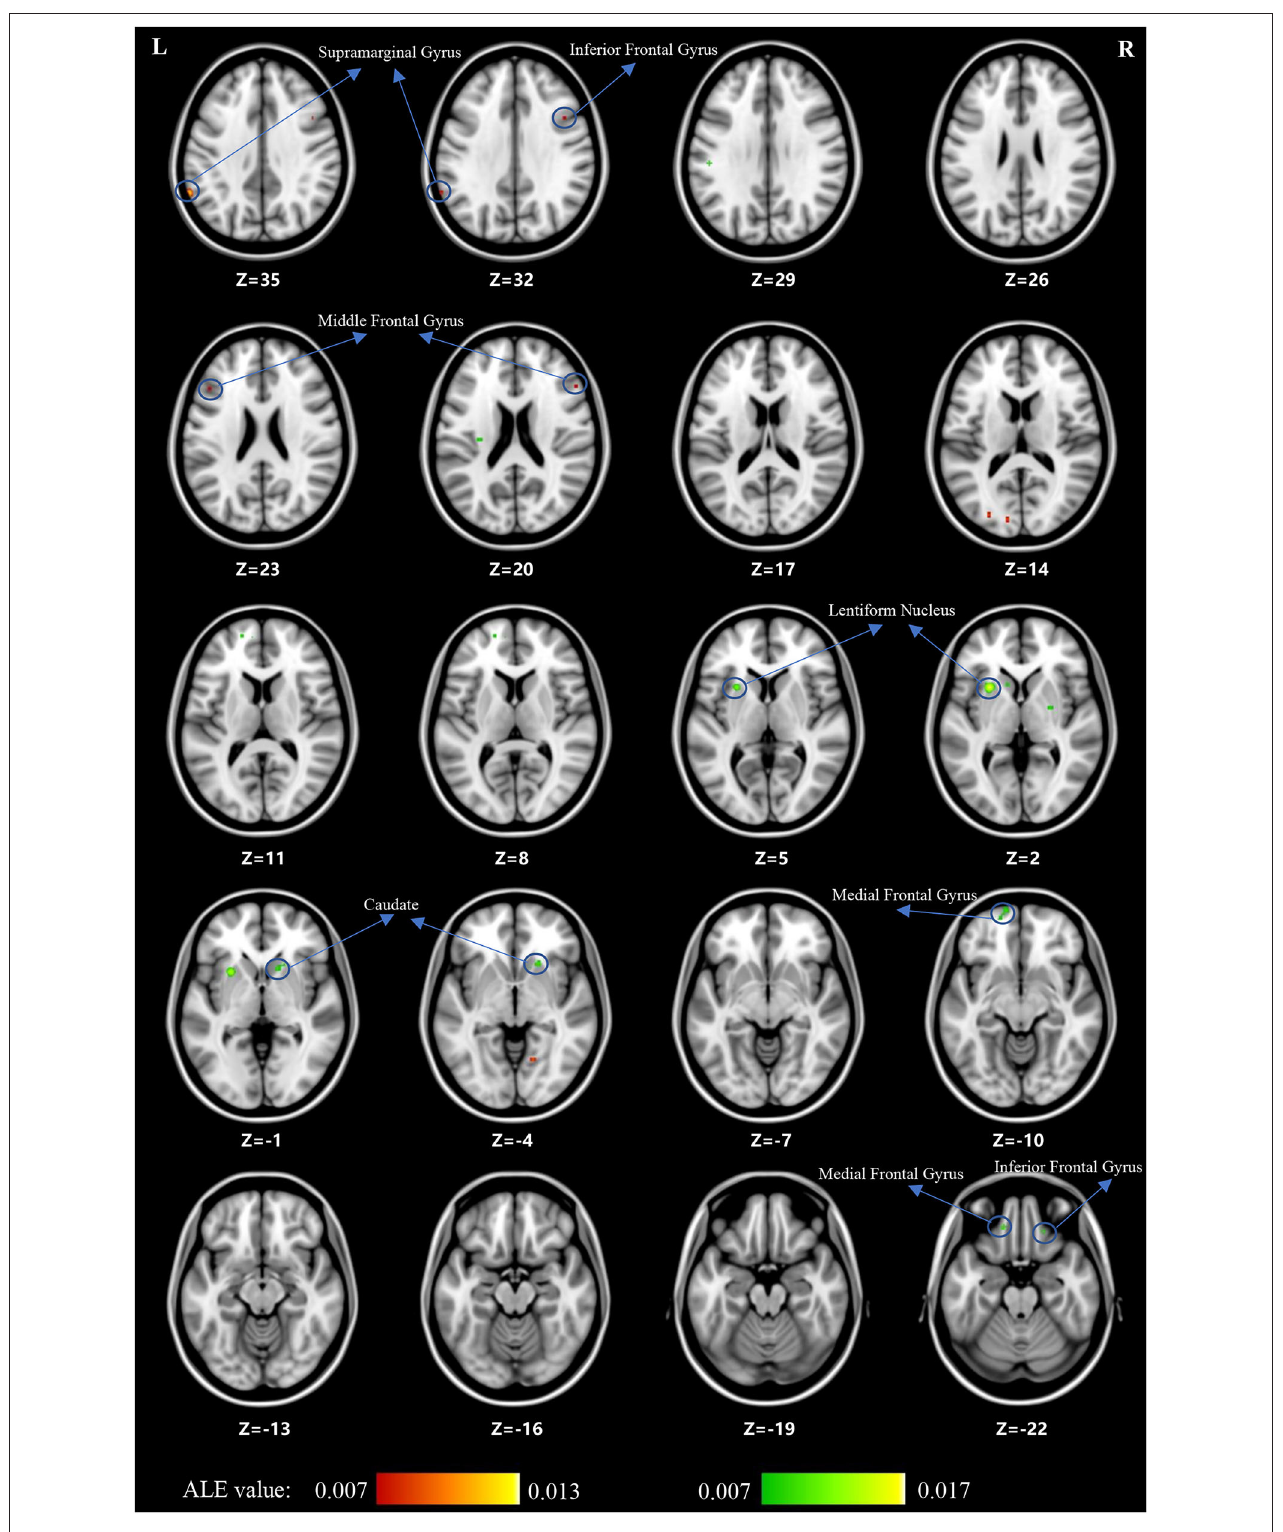
FIGURE 3 | The gray matter reduction (red) and increase (green) in OCD based on ALE analysis.